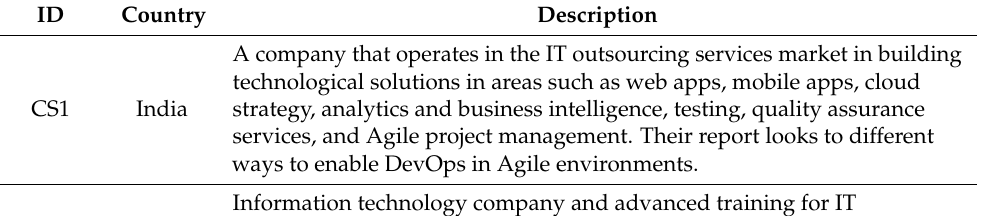
Table 2. Profiles of the case